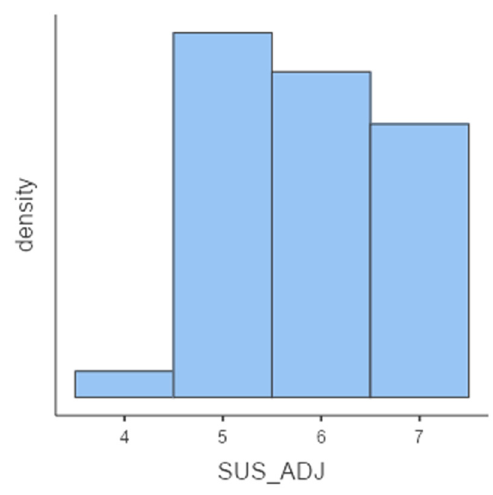
Figure 3. Graphic representation of the adjective rating.